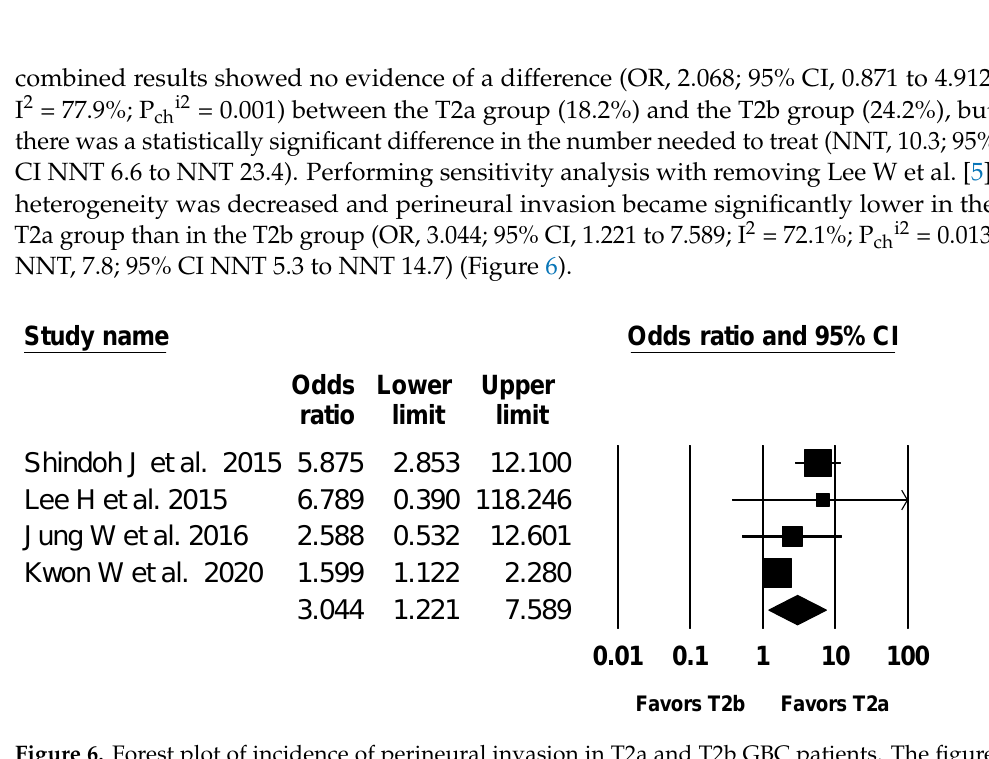
Figure 6. Forest plot of incidence of perineural invasion in T2a and T2b GBC patients. The figure Meta Analysis depicts individual trials as filled squares with relative sample size and the 95% confidence interval (CI) of the difference as a solid line. The diamond shape indicates the pooled estimate and uncertainty for the combined